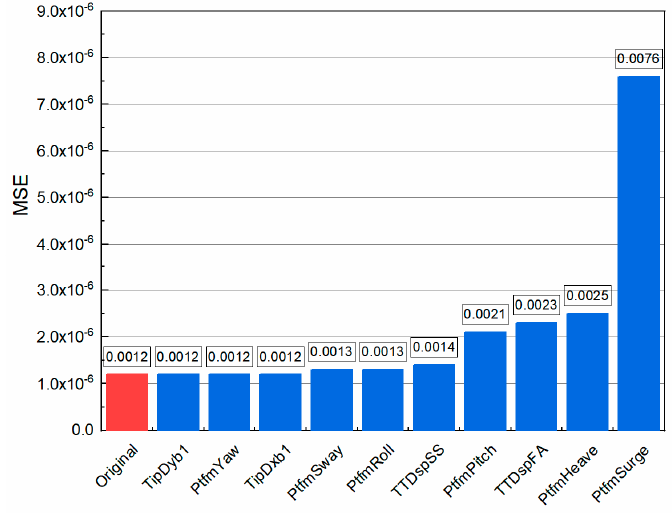
Figure 12. Variations of final MSEs in different sensitivity analysis scenarios.